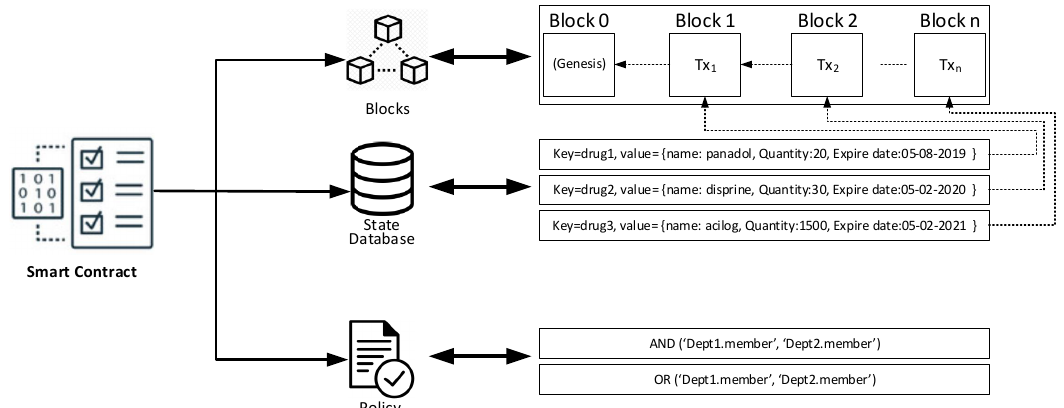
Figure 5. White-box representation of a blockchain node in a drug delivery supply chain